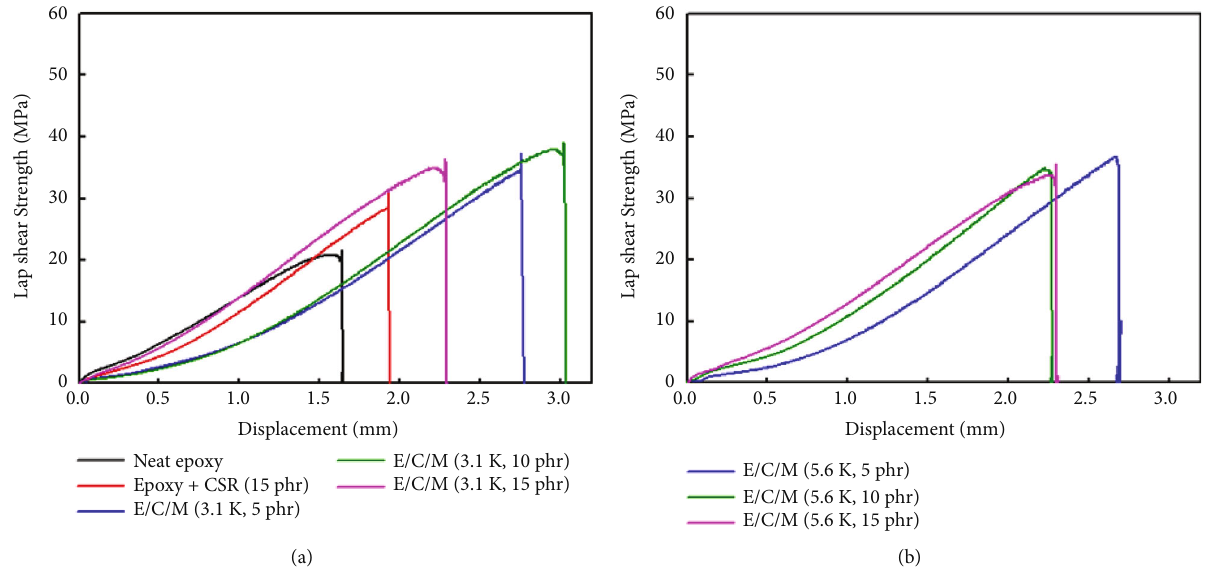
Figure 2: Lap shear strength – displacement curves obtained in the lap shear test for (a) E/C/M (3.1K) and (b) E/C/M (5.6K) with di ff erent phr